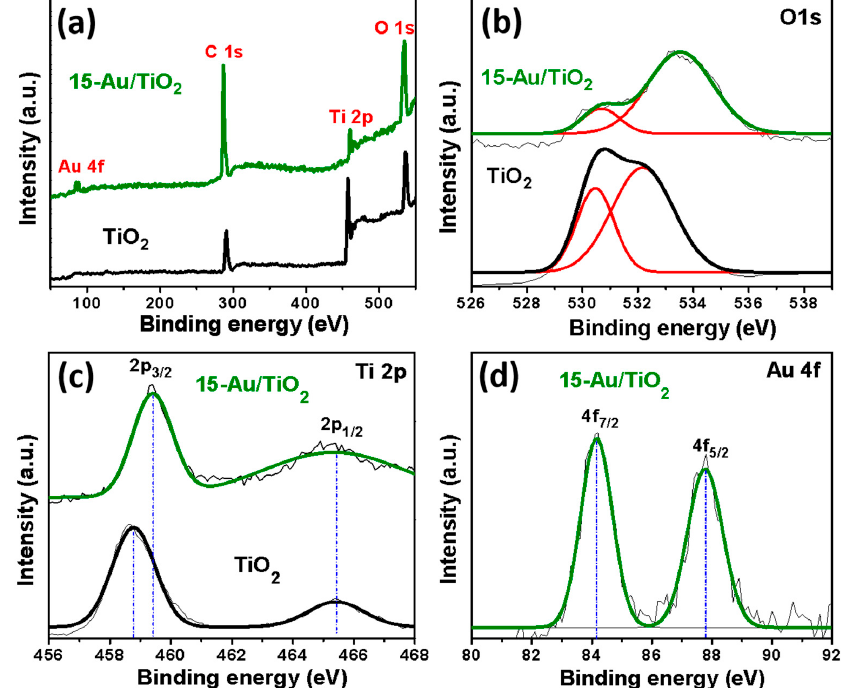
Figure 5. ( a ) Wide-scan and high-resolution X-ray photoelectron spectroscopy (XPS) spectra of ( b ) O 1s, ( c ) Ti 2p, and ( d ) Au 4f states of pristine TiO 2 and 15-Au / TiO 2 NF samples.